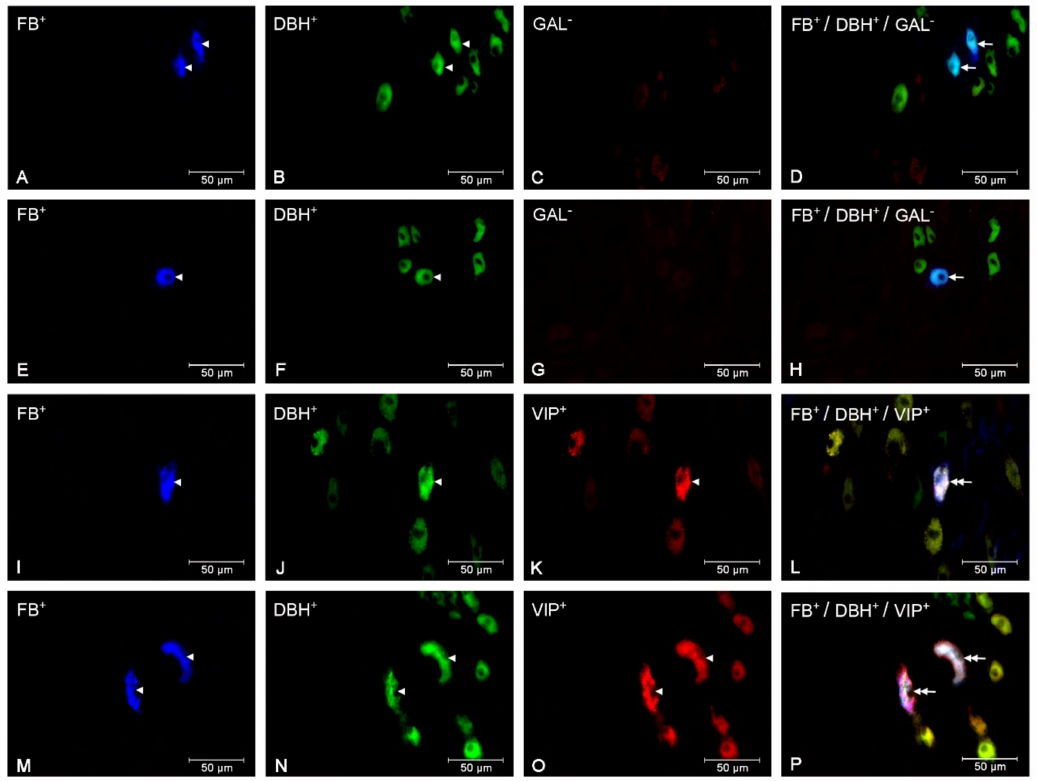
Figure 4. Micrographs demonstrating the presence D β H (B, F, J, N), GAL (C, G) and VIP (K, O) in the CaMG uterine perikarya of gilts from the CON ( A – D ), SAL ( I – L ) and E. coli ( E – H , M – P ) groups. The arrowhead indicates: FB-positive perikaryon, perikaryon presenting positive staining for D β H and perikaryon presenting positive staining for D β H and VIP. The arrow indicates FB-positive uterine perikaryon expressing D β H. The double arrow indicates FB-positive uterine perikaryon expressing D β H and VIP. The photographs (D, H, L P) were made by digital superimposition of three color channels: FB-positive (blue), D β H-positive (green) and GAL- or VIP-positive (red). In the CaMG from the CON group, two small uterine perikarya containing D β H but not GAL are visible ( A – D ). Following intrauterine bacterial injection, a drop in the number of small perikarya expressing D β